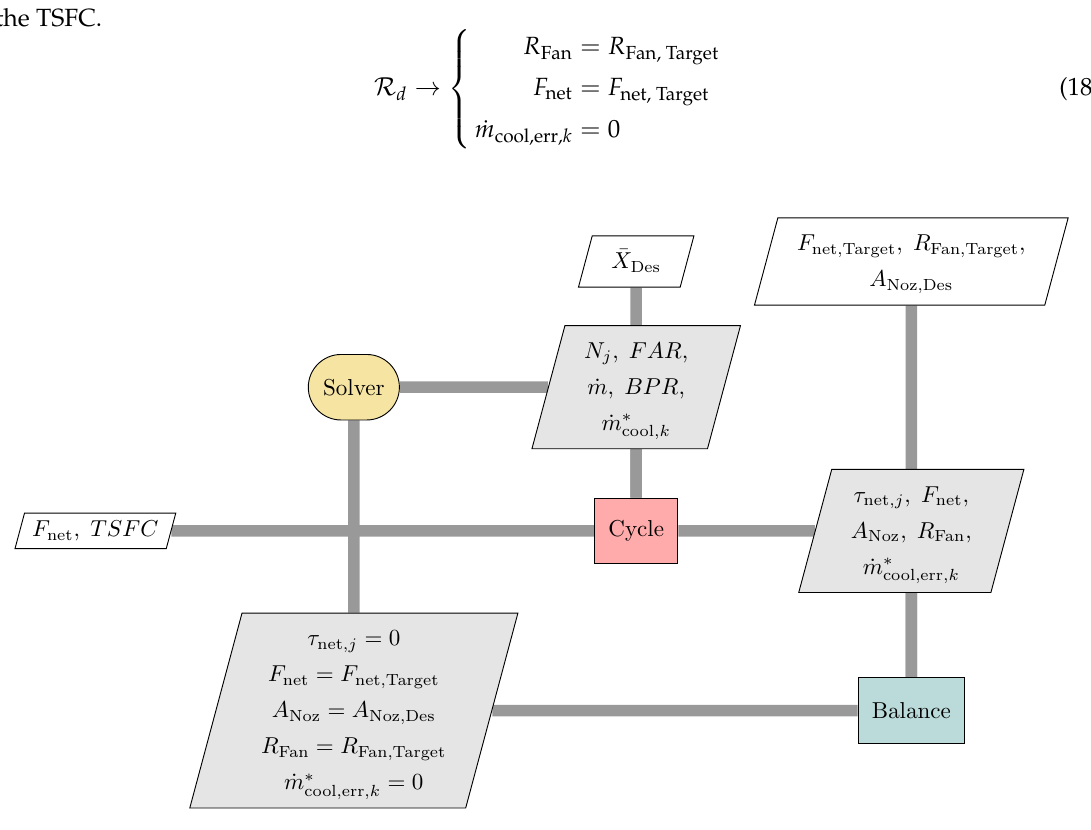
Figure 6. Reference engine model off-design analysis